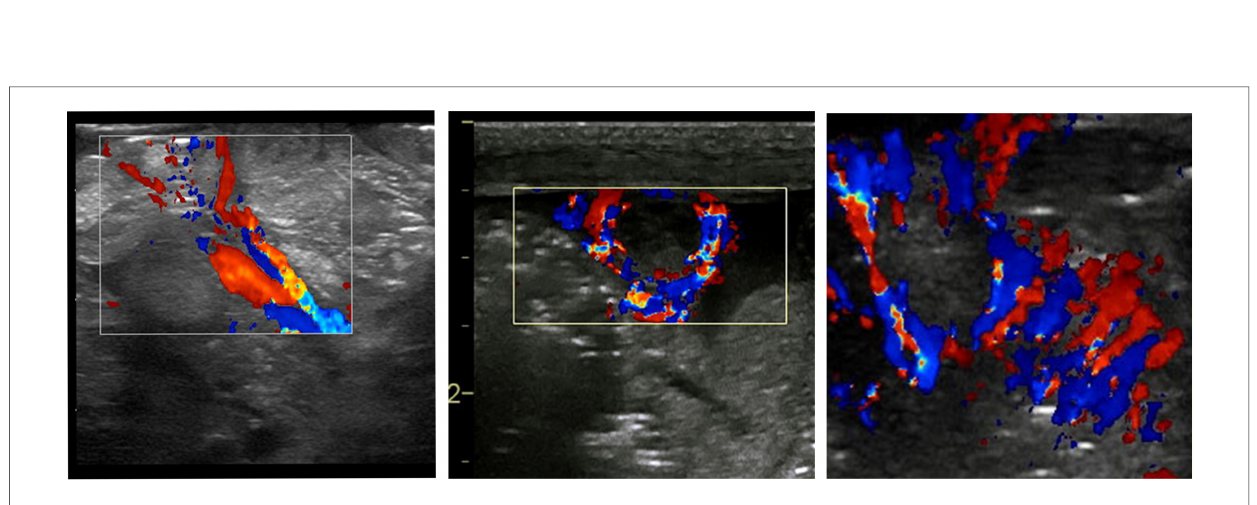
FIGURE 9 The sonographic appearance on the color Doppler showing the speci fi c vascular patterns seen in necrotizing enterocolitis: the Y, ring, and the Zebra